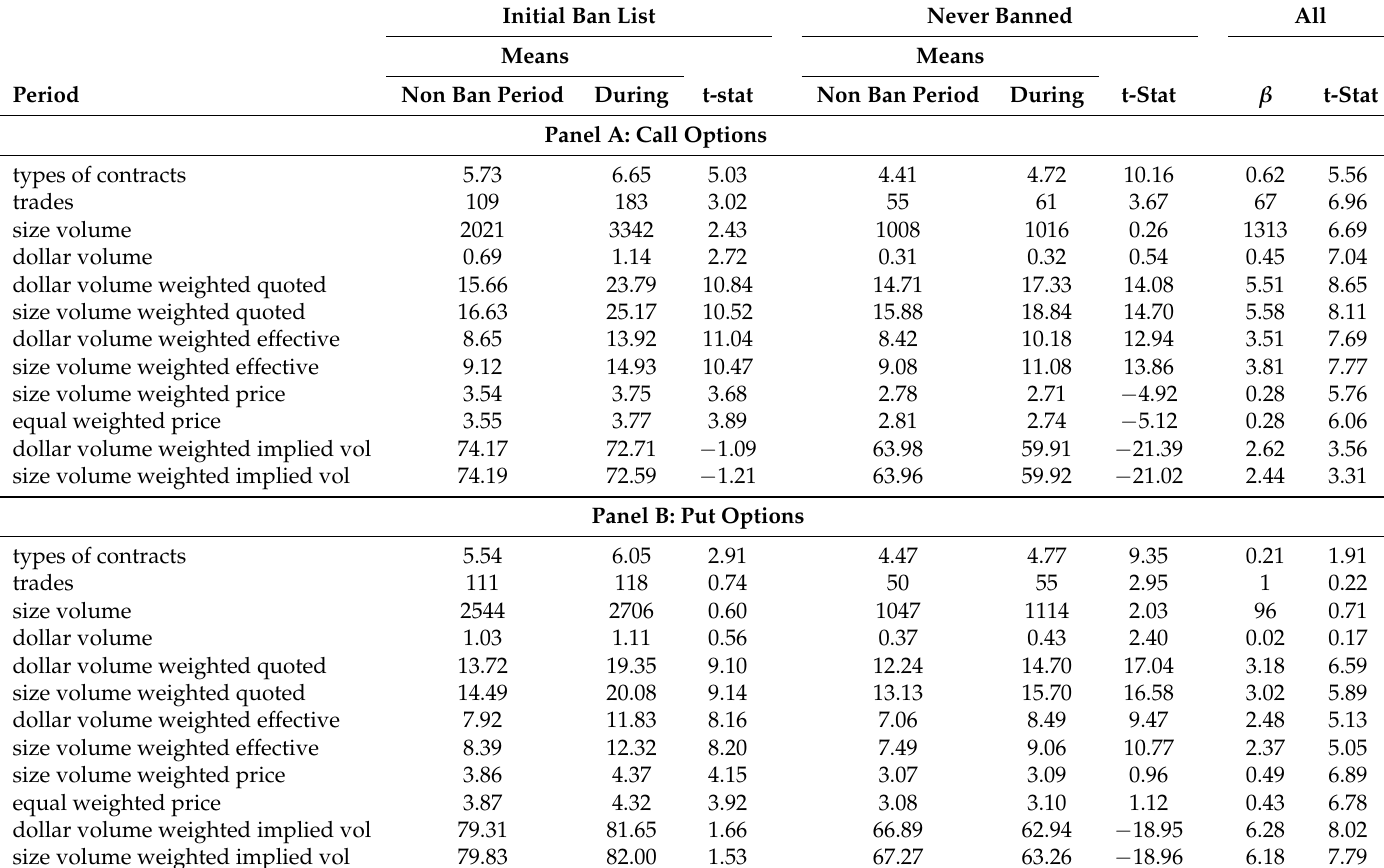
Table 2. Cross sectional means and t-statistics for option trade summary statistics: All